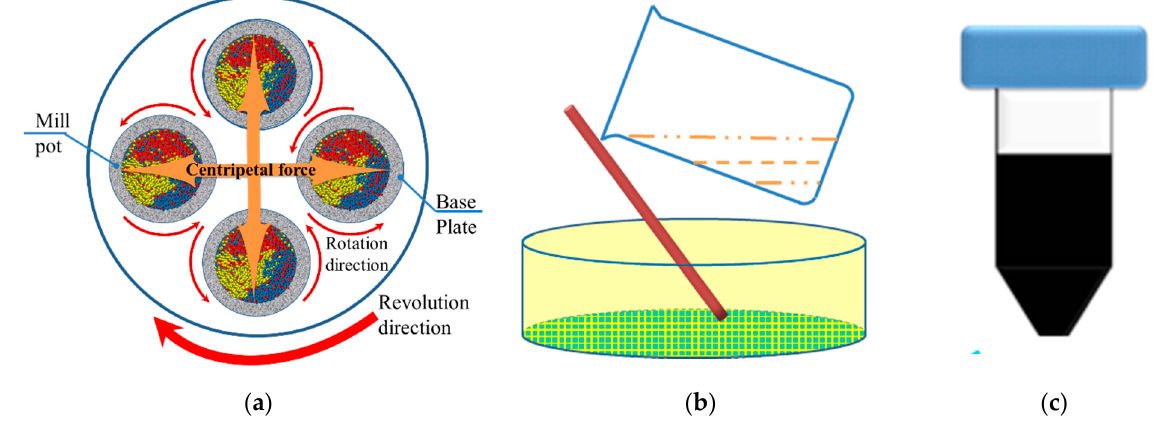
Figure 1. Fabrication process of Cu 2 ZnSnS 4 (CZTS) nanoparticle ink: ( a ) schematic of ball milling machine, ( b ) filtration of CZTS particles smaller than 32 μ m, ( c ) nanoparticle ink of CZTS.